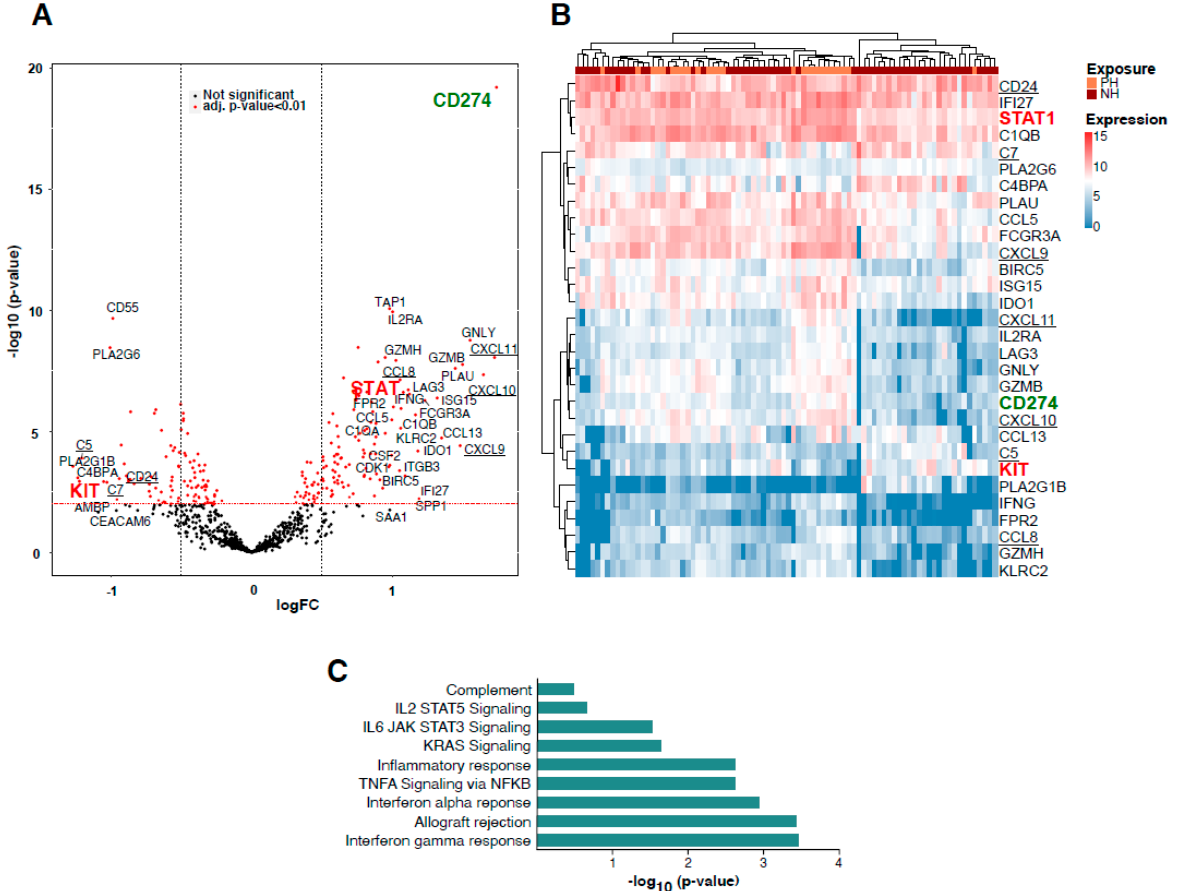
Figure 4. Immune profiling using the nCounter Immune Profiling panel. ( A ) Volcano plot showing differentially expressed genes between PH and NH LUADs ( p -value > 0.01 und fold change > 0.25.). Analyzed targets CD274, KIT, and STAT1 marked. ( B ) Cluster analysis using Euclidean distance of normalized NanoString mRNA expression between PH (orange) and NH (in brown) LUADs assembled into a heatmap. Analyzed targets CD274, KIT, and STAT1 marked in the list on the right side. ( C ) Barplot depicting the p -values of the most upregulated molecular pathways according to a GSEA analysis in PH LUADs. PH